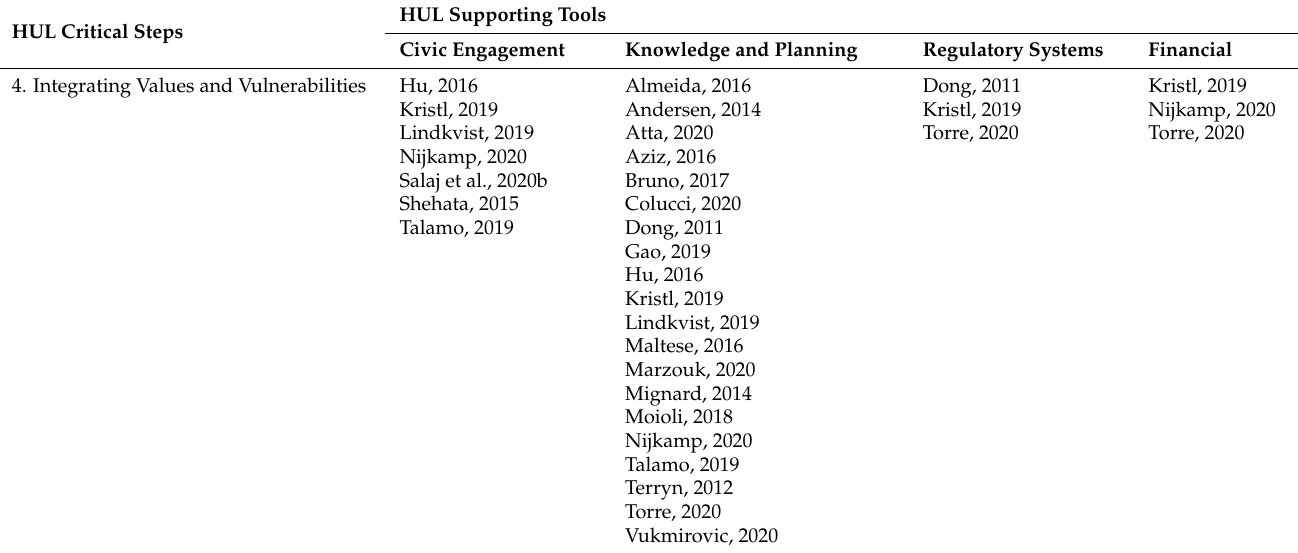
Table 4. List of authors discussing the integrating values and vulnerabilities supporting tools of the HUL approach within the urban heritage facility management